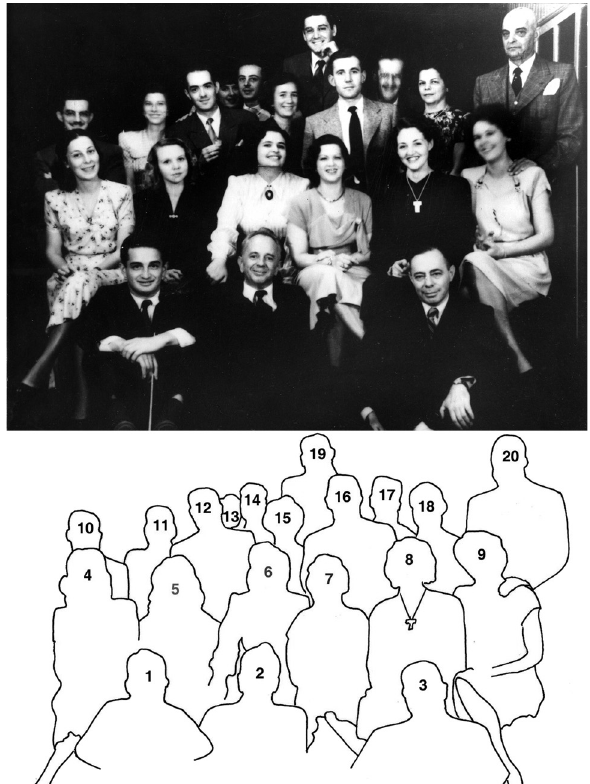
Figure 1 - Probable farewell party for Prof. Theodosius Dobzhansky, in the first half-year of 1949, at the Departamento de Biologia Geral of FFCL-USP, then located in the attic of the Jorge Street Mansion, at Alameda Glette 463, Campos Elíseos, São Paulo, SP. (From the archives of the Memory Committee of the Departamento de Genética e Biologia Evolutiva of the IB-USP) (Observation: this image was previously re- leased for illustrating an interview by Marco Antonio Coelho with Profes- sors Crodowaldo Pavan, Antonio Brito da Cunha and Erasmo Garcia Mendes, published in 1993 in Estudos Avançados 7:189-207). 1. Crodo- waldo Pavan, 2. Theodosius Grigorievich Dobzhansky, 3. André